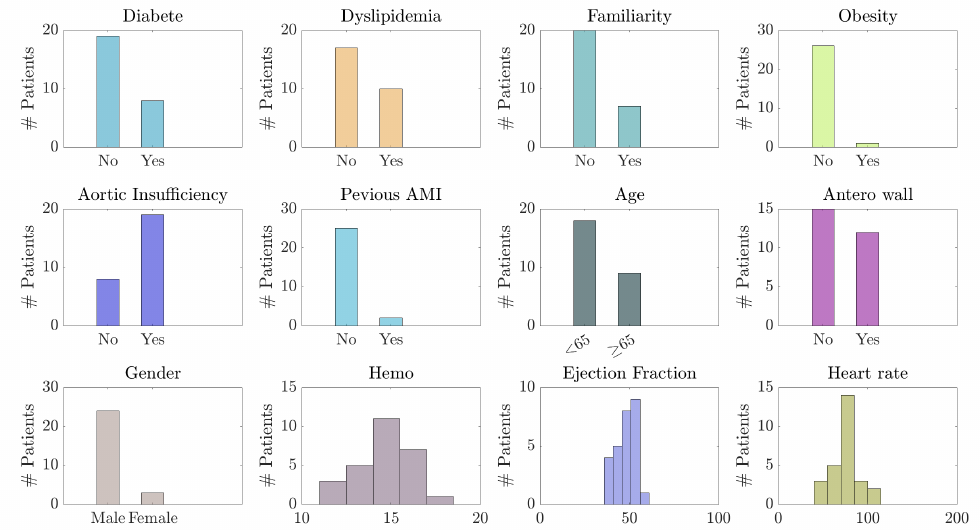
Figure 3. Distribution of all the available categorical and continuous covariates among the 27 STEMI patients of the study. Note that covariates such as ejection fraction, hemoglobin, and anterior wall are not included in the